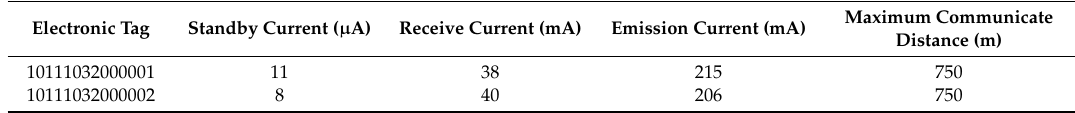
Table 2. Results of the Test and